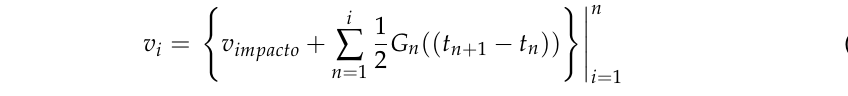
Figure 2. Weight drop vertical impact equipment manufactured exclusively for the developed experiments.